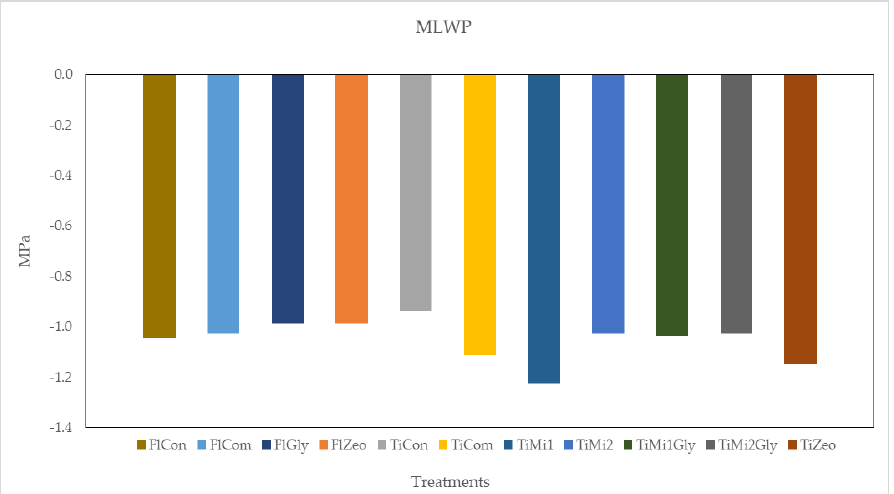
Figure 2. Midday Leaf Water Potential (June, 20 DAMB, second year). Data are the mean of 4 replicates. No significant differences were detected between the treatments by ANOVA. FlCon: flat soil, without any addition; FlCom: flat soil, with addition of compost (130 t ha −1 ); FlGly: flat soil, with addition of glycine-betaine; FlZeo: flat soil, with addition of zeolite; TiCon: soil tilled to form raised ridges of about 50 cm in rows, without any addition; TiCom: soil tilled to form raised ridges of about 50 cm in rows, with addition of compost (80 t ha −1 ); TiMi1: soil tilled to form raised ridges of about 50 cm in rows, with addition of microbial consortium 1; TiMi2: soil tilled to form raised ridges of about 50 cm in rows, with addition of a microbial consortium 2; TiMi1Gly: soil tilled to form raised ridges of about 50 cm in rows, with addition of a microbial consortium 1 and addition of glycine- betaine; TiMi2Gly: soil tilled to form raised ridges of about 50 cm in rows, with addition of a micro- bial consortium 2 and addition of glycine-betaine; TiZeo: soil tilled to form raised ridges of about 50 cm in rows, with addition of zeolite. 3.4. Leaf Gas Exchanges No significant differences were detected among treatments for leaf gas exchanges when data from apical and basal leaves all together or from basal leaves alone were ana- lyzed. Significant differences were observed for apical leaves when analyzed alone, as shown in Figure 3, where the apical leaf gas exchanges measured in July, in the mid of the vegetative season (50 DAMB) of the third year, are reported: the highest values of gs, A and E were observed in treatment TiMi2, and the lowest in FlZeo. Substomatal CO 2 con- centration was lowest in TiMi1Gly and TiZeo, highest in TiMi1.